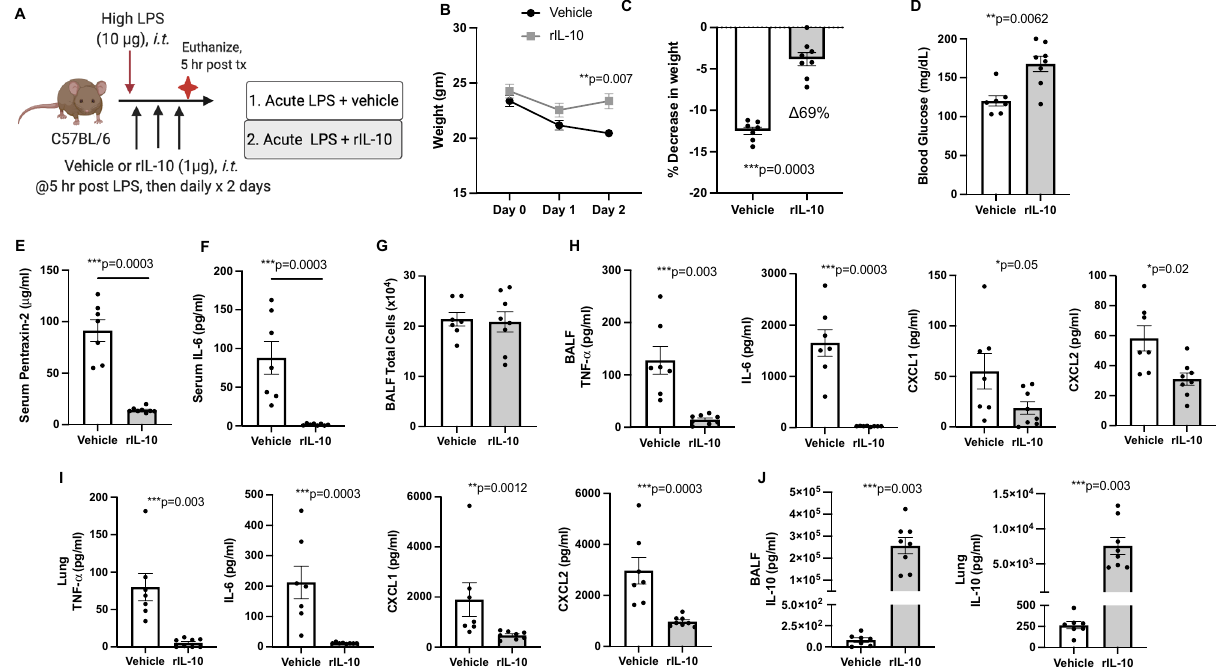
Figure 3. Instilled rIL10 treatment hastens recovery of systemic and airway inflammatory events following a one-time LPS exposure. ( A ) Schematic of experimental design (Created with BioRender.com). ( B ) Line graph depicts mean with SEM bars of weight changes over time. Scatter plot graphs depict mean with SEM bars between treatment groups of percent change in weight at day 3 versus baseline ( C ), blood glucose levels ( D ), serum pentraxin-2 levels ( E ), serum IL-6 levels ( F ). Total cellular influx depicted in bronchoalveolar lavage fluid (BALF) ( G ). Levels of airway inflammatory markers determined by ELISA from BALF ( H ) and lung homogenates ( I ) and levels of BALF and lung homogenate IL-10 ( J ). N = 7 (vehicle) and N = 8 (rIL-10) mice/ group from 2 experimental runs. Statistical significance denoted by asterisks (*p < 0.05, **p < 0.01, ***p < 0.001, ****p <